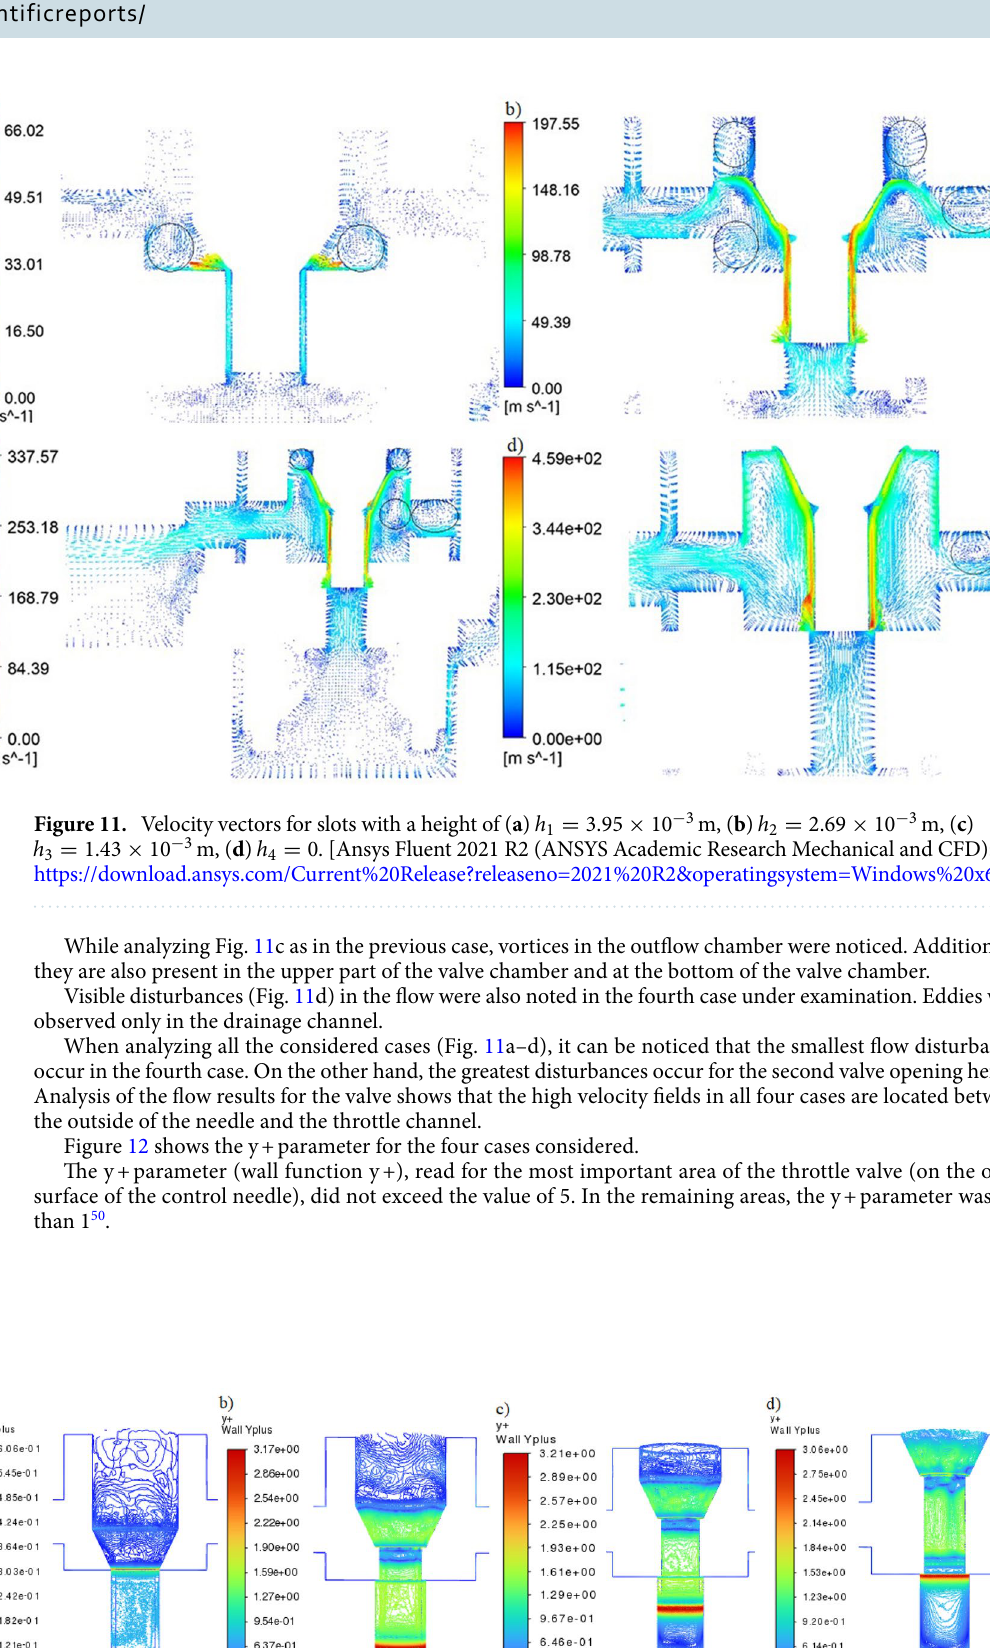
Figure 12. Y + for the following cases: ( a ) following cases: ( a ) h 1 3 m, ( d ) h 1.43 10 ( c ) h 3 − = ×